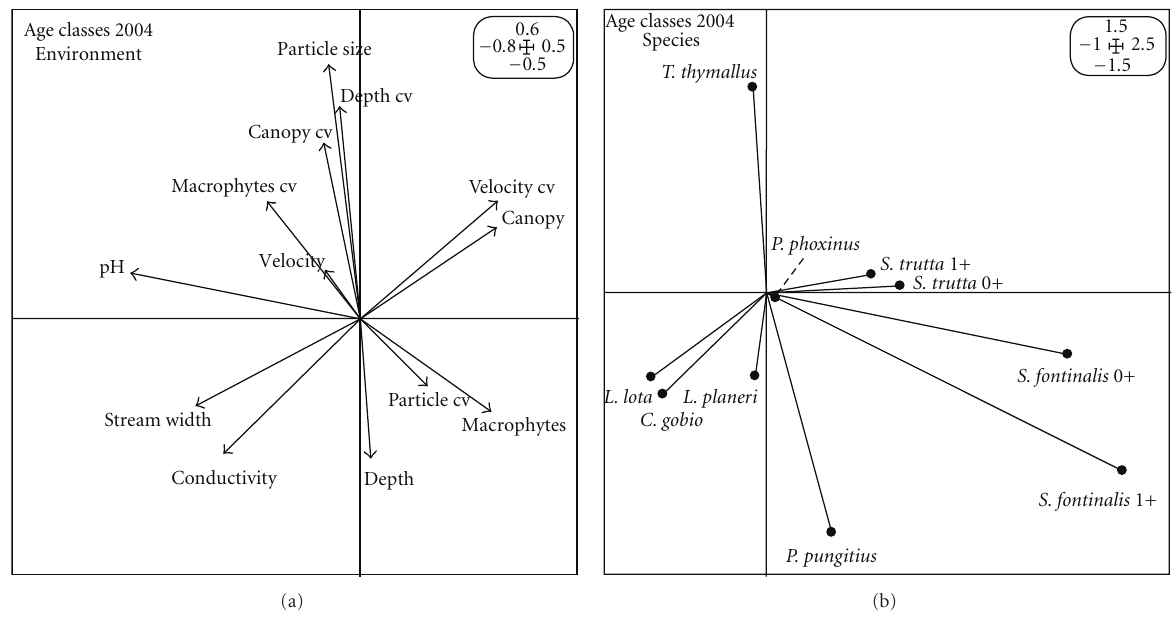
Figure 3: Environmental (a) and species (b) vectors on the first factorial plane of the OMI analysis. Analysis was based on the 2004 data, with the age classes of brown trout ( Salmo trutta ) and brook trout ( Salvelinus fontinalis ) shown separately.